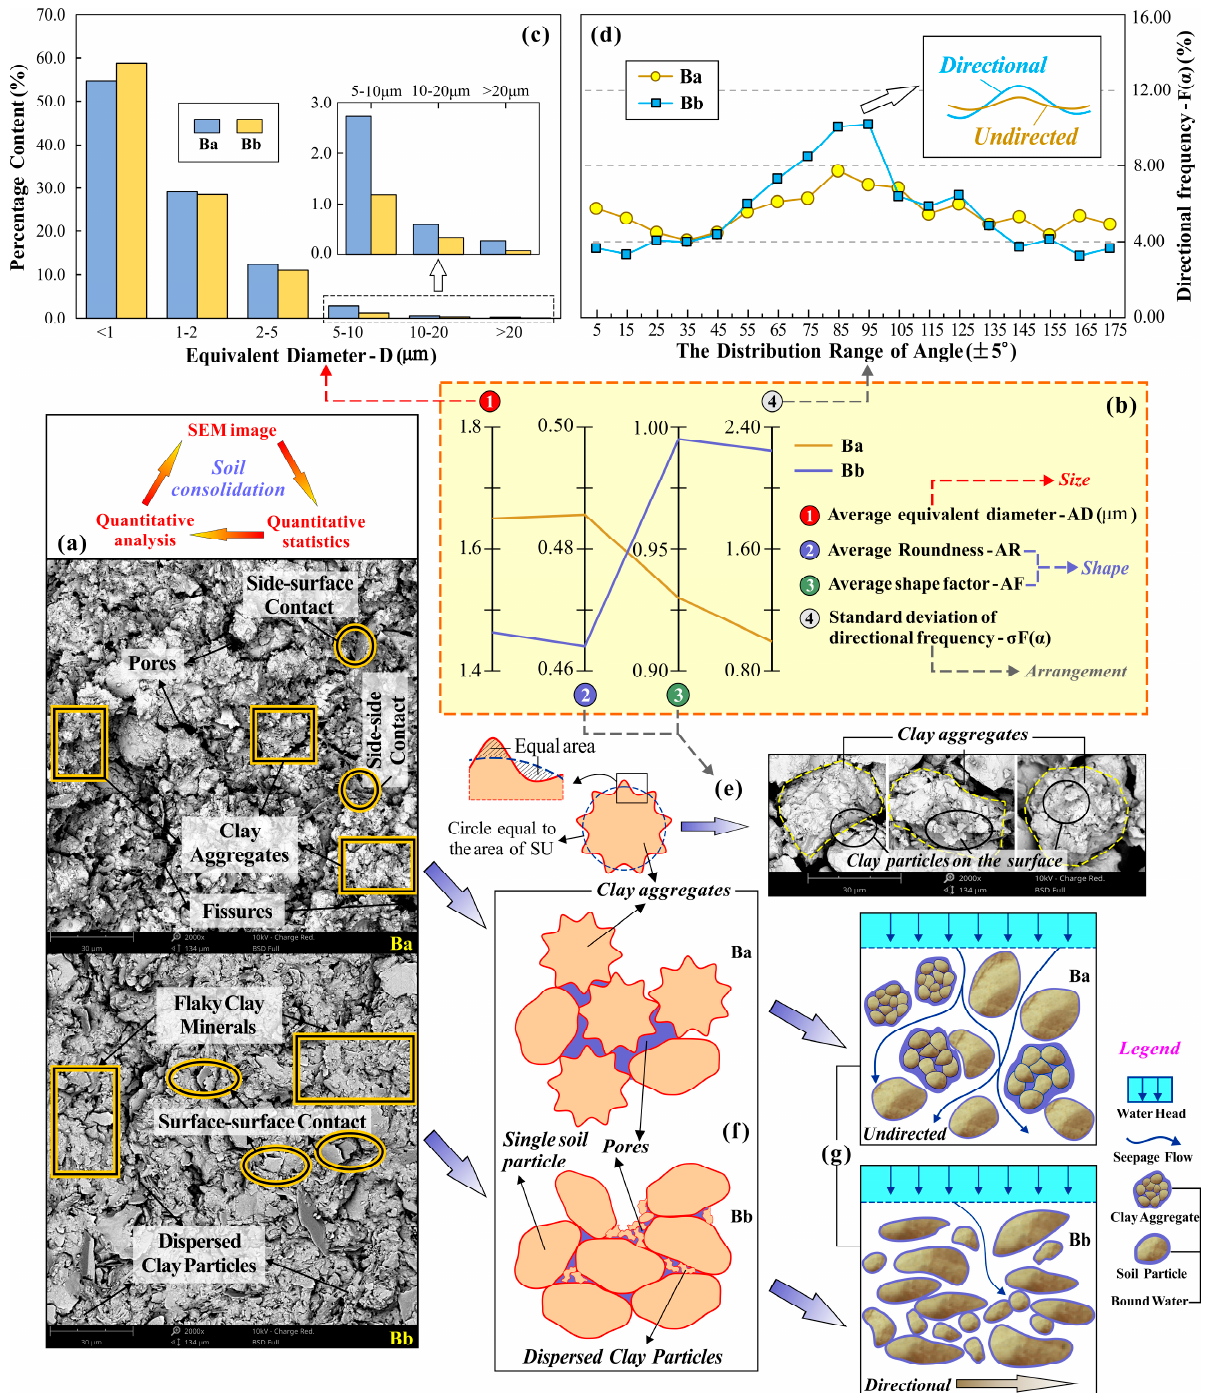
Figure 9. Quantitative description of microstructure for clay around Ba (CLBA) and clay around Bb (CLBB). ( a ) SEM images of clay in 2000 × and micro-scale analysis process; ( b ) statistical microscopic parameters; distributions of ( c ) equivalent diameter and ( d ) directional frequency; ( e ) diagram of the suborbicular structural unit (SU) with complex shape and clay aggregates in 2000 × ; diagrams of ( f ) shape and ( g ) arrangement characteristics of